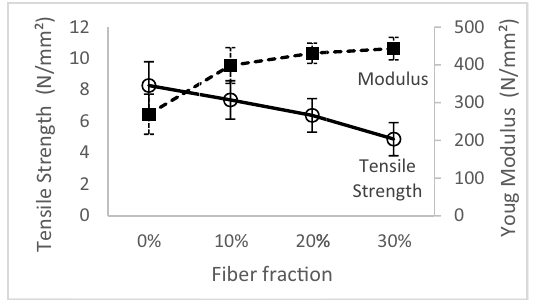
Figure 2: Tensile strength and Young modulus of r - HDPE/bamboo